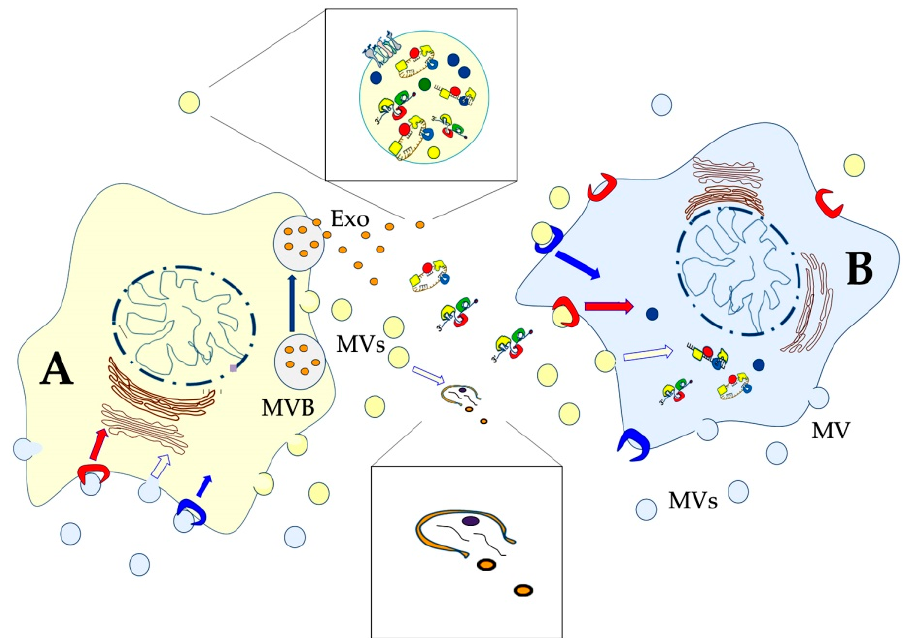
Figure 4. Schematic drawing of two cells that communicate with each other by exchanging extracellular vesicles of di ff erent sizes and origins. Some vesicles directly bud from the plasma membrane (microvesicles, MVs), while exosomes (Exo) derive from the multivesicular body (MVB). For clarity, vesicles have been depicted in the same colour as the producing cell: yellow produced by the yellow cell (A), and light blue produced by the light blue cell (B). After release, some EVs are quickly lysed and release their content into the extracellular space (lower enlarged view). Some of them contain matrix metalloproteases and other hydrolytic enzymes responsible for the digestion of various ECM components. Alternatively, intact EVs can interact with the target cells that can internalize them through a variety of pathways [145]. The vesicles can also directly fuse with the plasma membrane of the target cell. Both MVs and exosomes are endowed with proteins, lipids, and nucleic acids that can influence di ff erent physiological and pathological functions of the target cell (upper enlarged view).